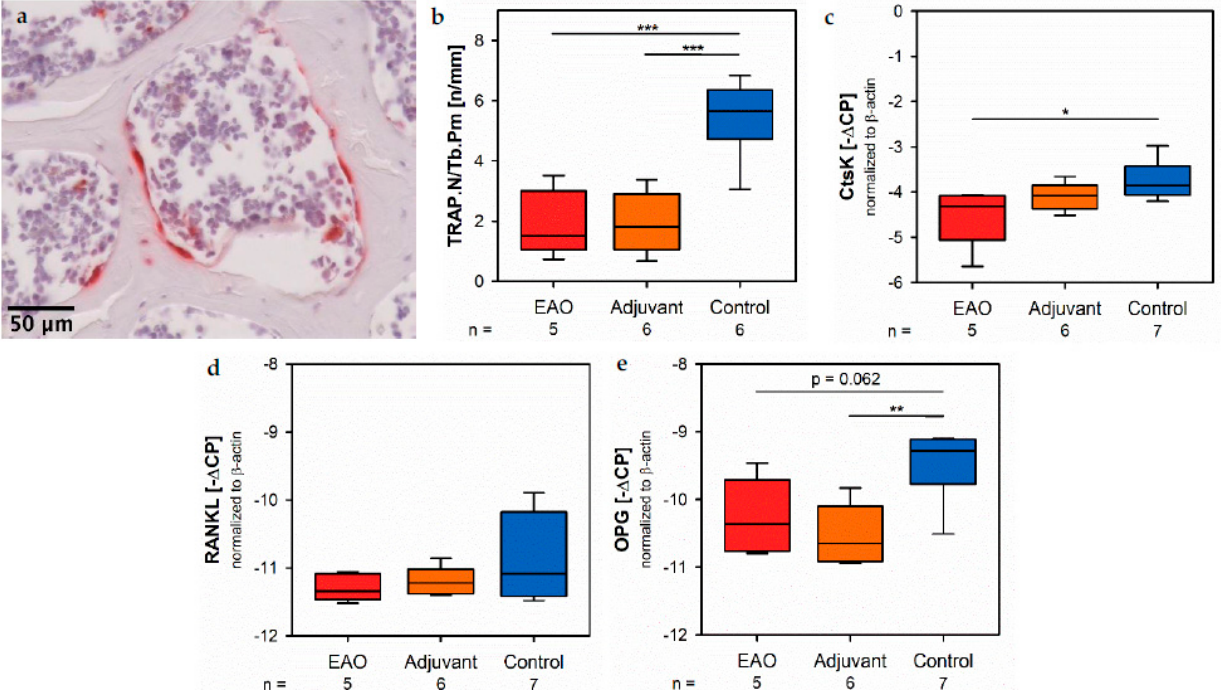
Figure 10. Osteoclasts. ( a ) Enzyme histochemical staining of tartrate resistant acid phosphatase (TRAP, red) in vertebral body L3 from an untreated mouse. ( b ) Histomorphometrical calculation of number of TRAP positive cells per trabecular perimeter (TRAP.N/Tb.Pm) in enzyme histochemical-stained vertebral bodies L3. mRNA expression of ( c ) cathepsin K (CtsK), ( d ) receptor activator of nuclear factor-kappa B ligand (RANKL) and ( e ) osteoprotegerin (OPG) in real-time RT-PCR of vertebral bodies Th10. Mice were immunized with testicular homogenate in adjuvant (EAO), adjuvant alone (adjuvant) or remained untreated (control). * p < 0.05; ** p < 0.01; *** p < 0.001.